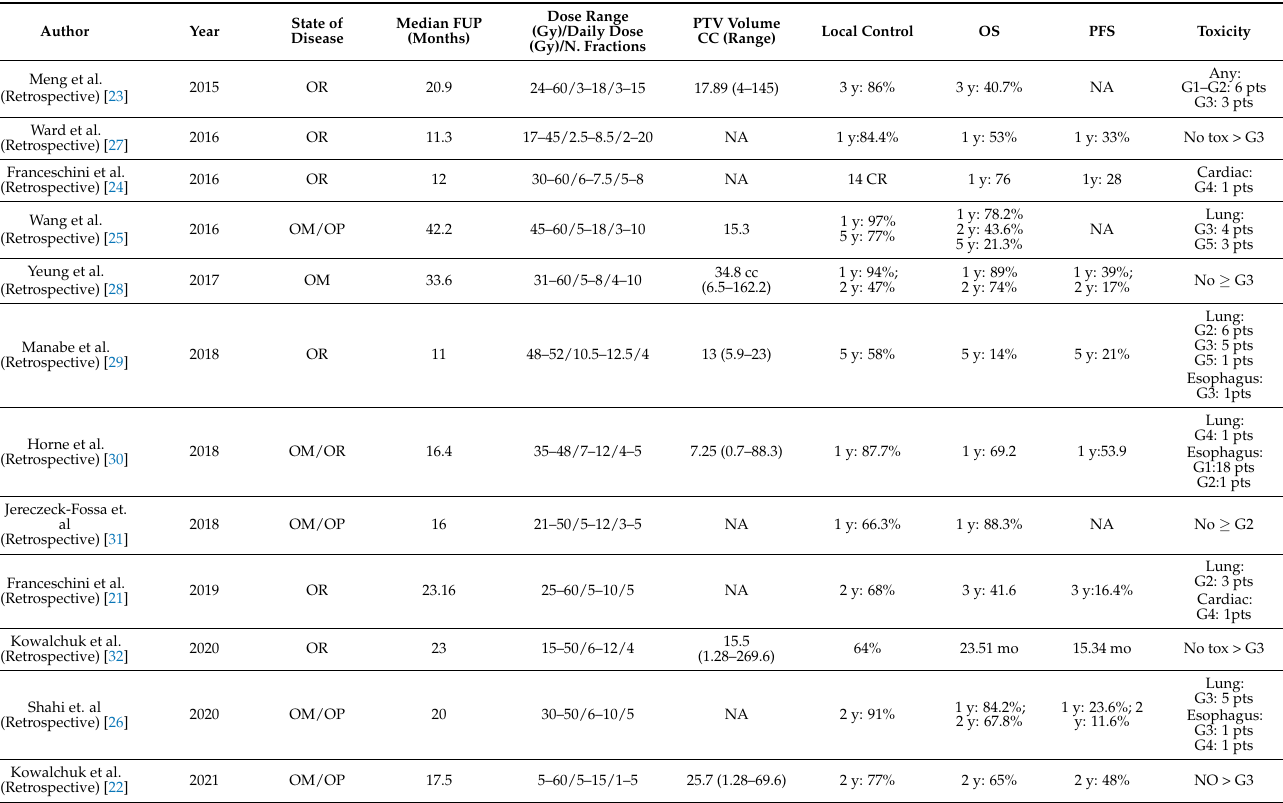
Table 2. Studies selected for systematic review: treatment characteristics and clinical